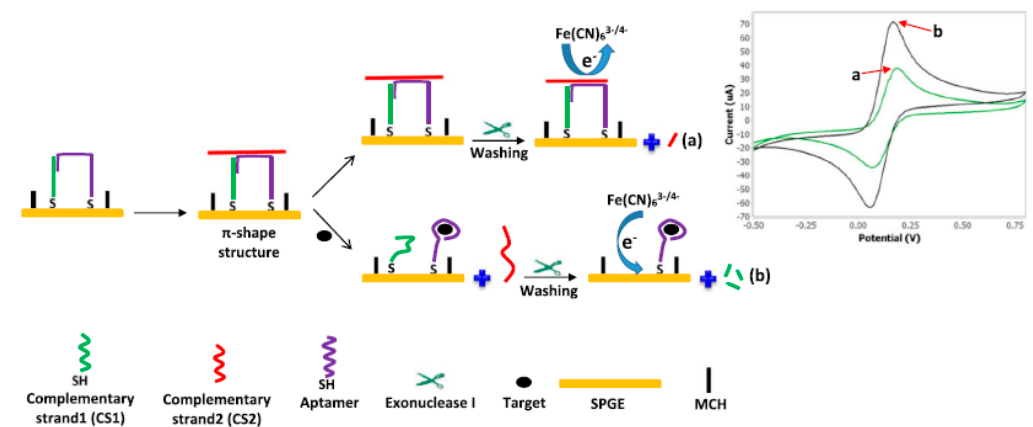
Figure 2. Construction procedure of the introduced π -shape electrochemical aptasensor for AFB1. ( a ) As seen, in the absence of AFB1, many sections of the π -shape structure remained intact and the redox mediator had no access to the electrode surface, resulting in a poor current signal. ( b ) Moreover, in the presence of AFB1, Apt attached to AFB1 and left the aptamer (Apt)-complementary strands (CSs). Exo I digested CS1, causing greater access of [Fe(CN) 6 ] 3-/4- to the electrode surface, producing a powerful current signal. Reprinted with permission from [4]. Copyright 2017, Elsevier.